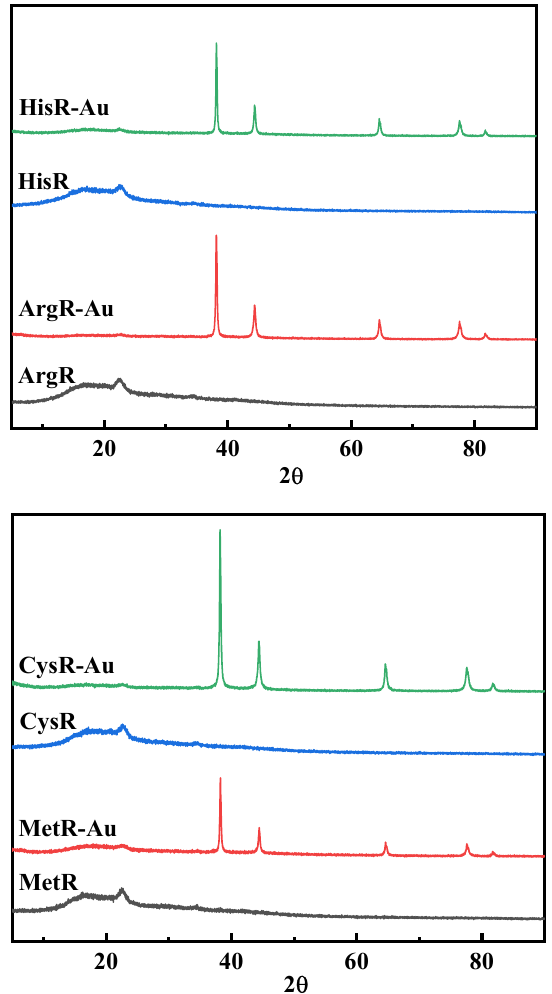
Figure 7. XRD spectra of Au-loaded amino acid resins.